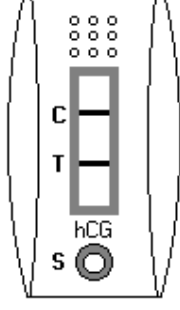
Figure 2. Positive Result Two distinct red lines appear. One line should be in the control region (C) and another line should be in the test region